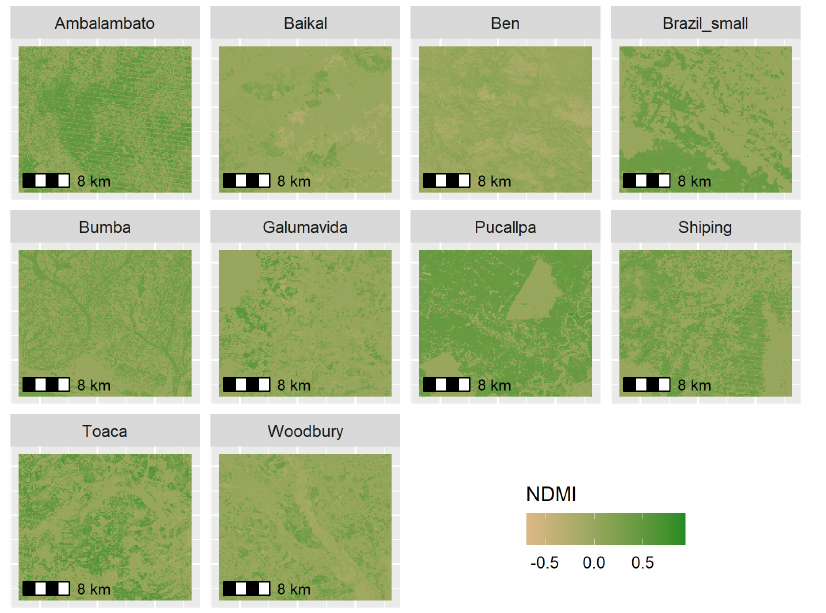
Figure 5. The most recent layer of time series datasets used as input for bfastmonitor processing algorithm. Titles are toponyms.